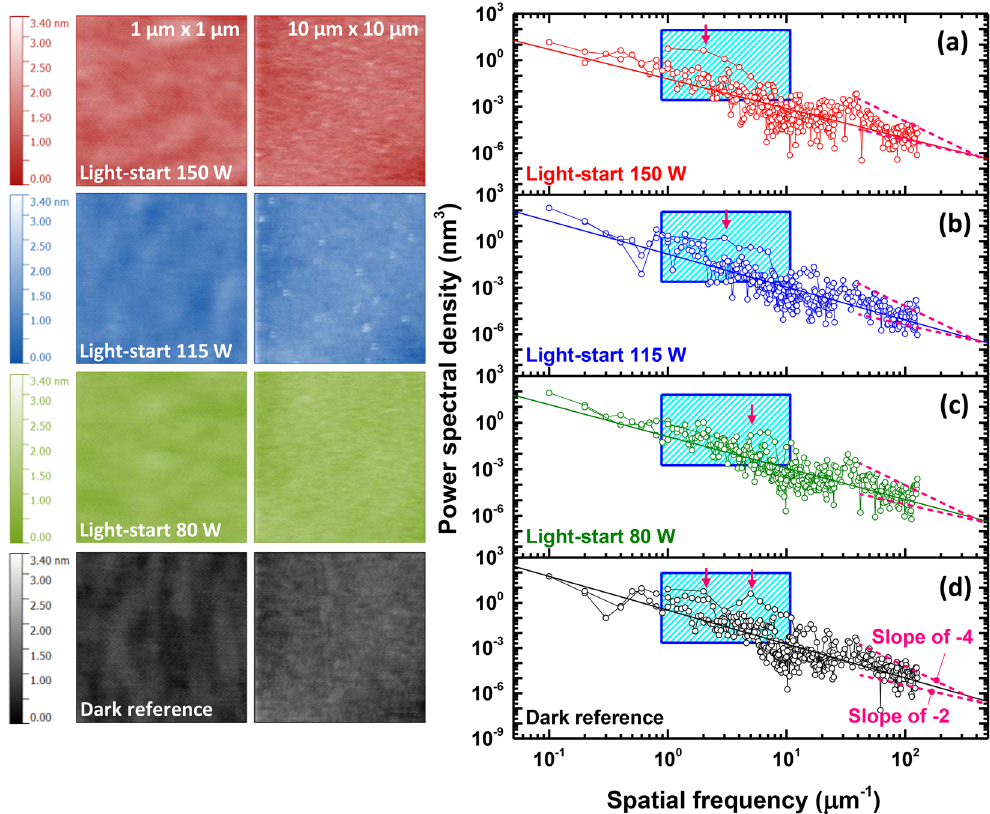
Figure 3. The left-hand portion of the figure displays 1 × 1 μ m 2 and 10 × 10 μ m 2 surface AFM images of the light-start samples and the dark reference sample. ( a – d ) Displays their corresponding PSD curves. The curve slopes approached 2 with increasing Xe lamp power. Regions of elevated PSD shifted to lower spatial frequencies with higher lamp power, which indicates that the period of the hillocks on the sample surface increased. The bright circular dots in the AFM images are associated with SeO 2